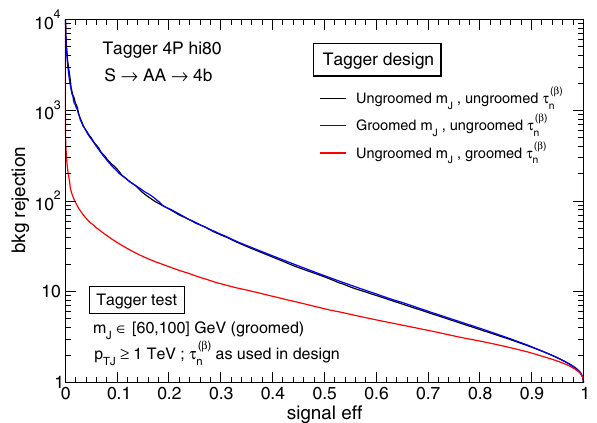
Fig. 8 Comparison of the performance of the 4P hi80 tagger using groomed versus ungroomed quantities